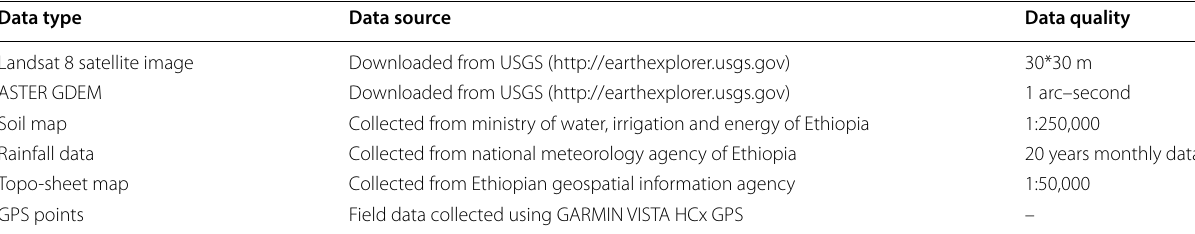
Table 1 The types, sources and quality of RUSLE input data used in this study Data type Data source Landsat 8 satellite